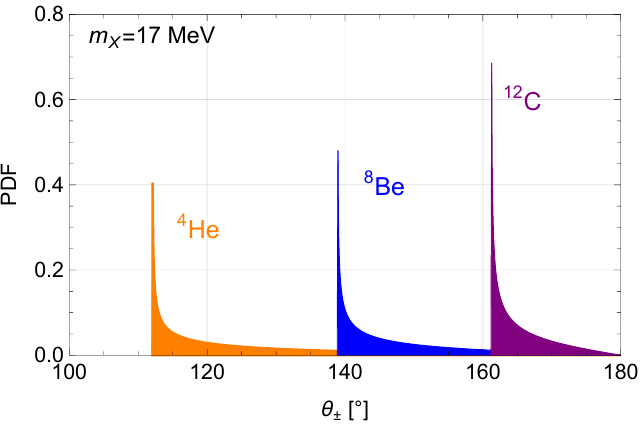
Figure 2 . Normalized distributions of the e + e − opening angles from the 8 Be (blue), 4 He (orange) and 12 C (purple) nuclear